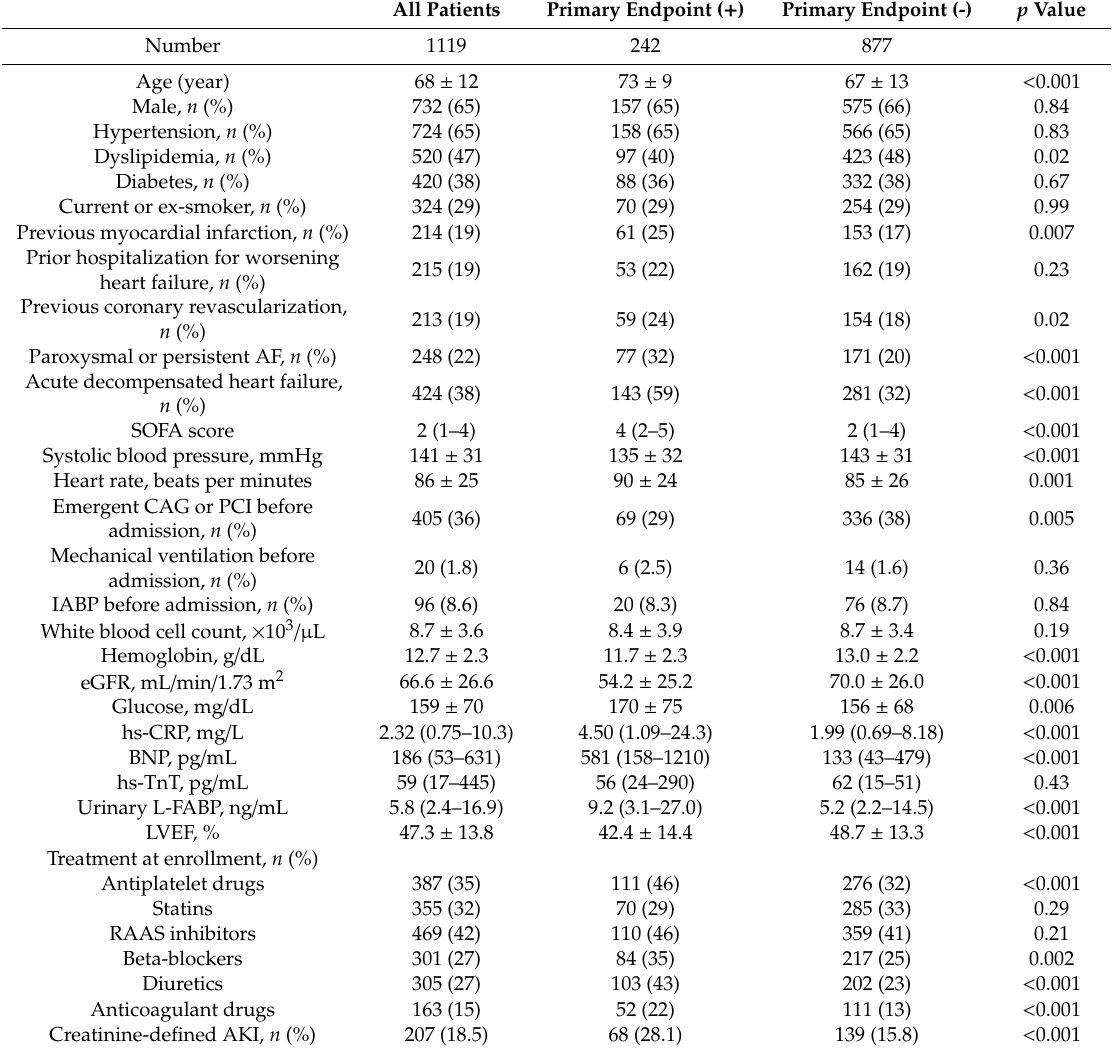
Table 2. Baseline characteristics of study population according to primary